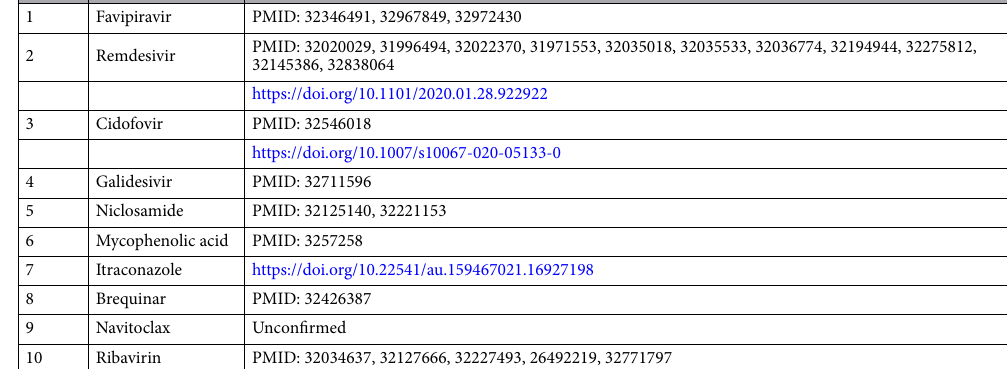
Table 6. The predicted top 10 drugs associated with SARS-CoV-2 on dataset 2.